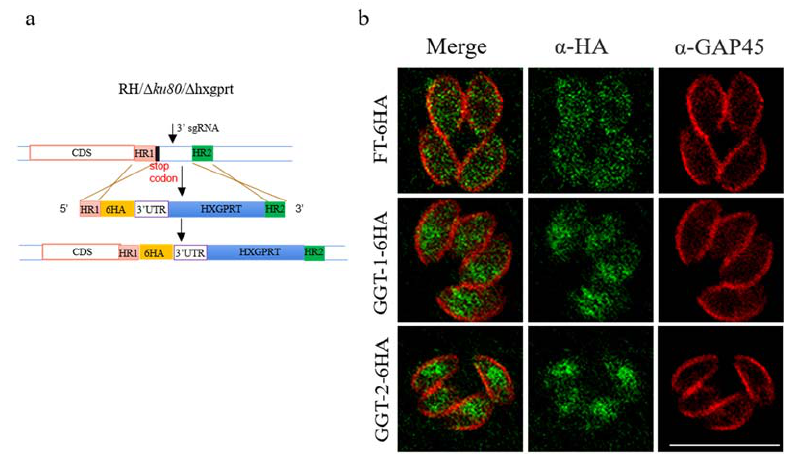
Figure 2. FT, GGT-1 and GGT-2 are localized in the cytoplasm of parasites. ( a ) The model of target genes (FT, GGT-1 and GGT-2) tagged with HA at the C-terminal under the background strain RH Δ ku80 Δ hxgprt using genome-editing technology. ( b ) IFA was used to identify the localization of FT, GGT-1 and GGT-2. GAP45 was used to label the outer plasma of the parasite (red color) and the target proteins were identified by ant-HA antibody (green color). Scare bar: 10 µ M.